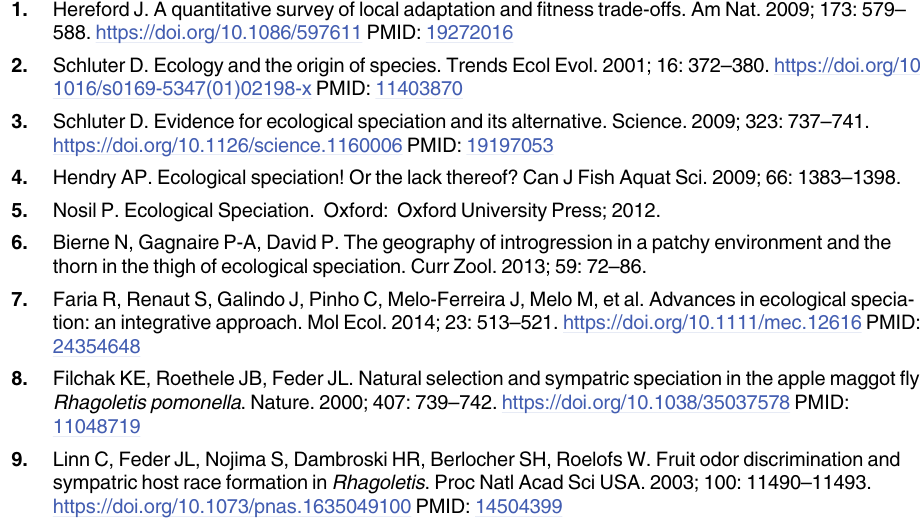
S2 Fig. Pairwise plots of morphological traits. (PDF) S1 Table. Ecological features of the collection sites.